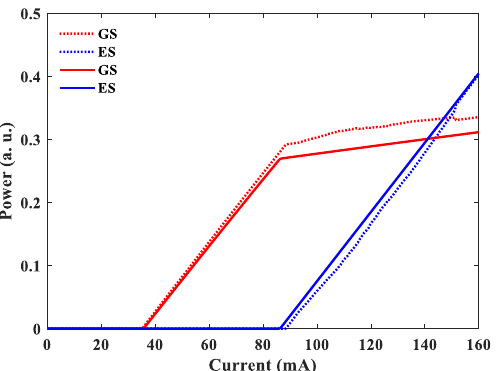
Figure 2. Normalized output power as a function of the injection current for a TSQDL under free-running (solid lines) or optical feedback with a feedback strength of k = 0.11 (dotted lines).